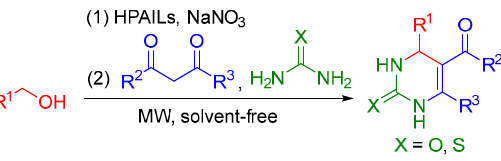
Scheme 1. Tandem oxidation process (TOP) for the Biginelli reaction starting directly from alcohols.